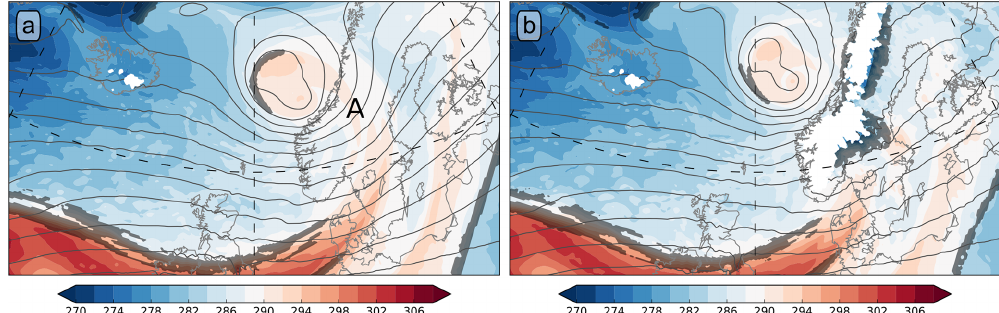
Figure 7. As Fig. 2h, but for (a) the Ocean simulation and (b) the Double simulation. For the meaning of “A”, refer to the main text.